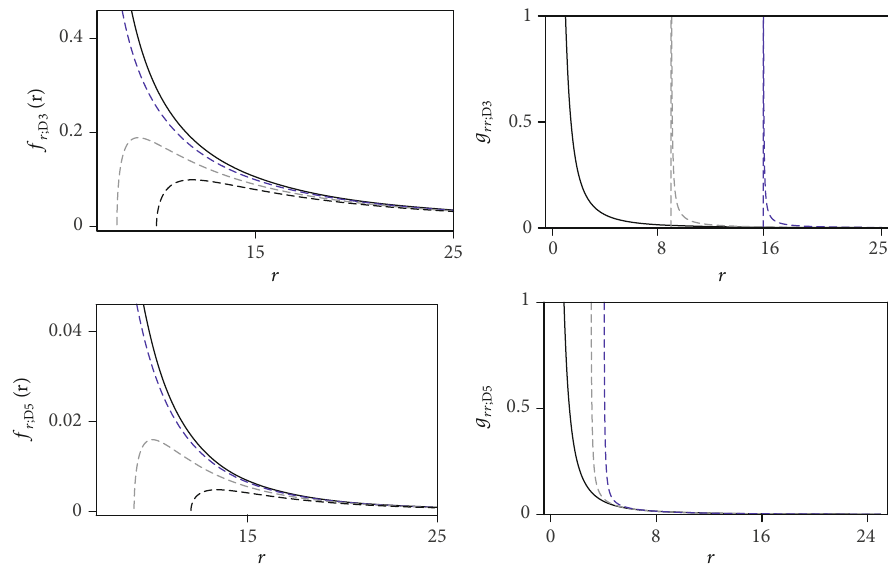
Figure 3: The behavior of the derivative of the D3-brane world volume fi eld with respect to r with L = 1, r = 7 , ω = 0 (black-solid), ω = 5 0 component of the D3-brane induced (blue-dashed), ω = 8 (gray-dashed), and ω = 10 (black-dashed) (up-left). The behavior of the g rr = 0 (black-solid), r = 3 (gray-dashed), and r = 4 (blue-dashed) (up-right). The behavior of the world volume metric with L = , r 0 0 0 = 7 , ω = 0 (black-solid), ω = 5 (blue-dashed), ω = 9 (gray- derivative of the D5-brane world volume fi eld with respect to r with L = 1, r 0 component of the D5-brane induced world volume metric dashed), and ω = 12 (black-dashed) (down-left). The behavior of the g rr with L = 1 , r = 0 (black-solid), r = 3 (gray-dashed), and r = 4 (blue-dashed) 0 0 0